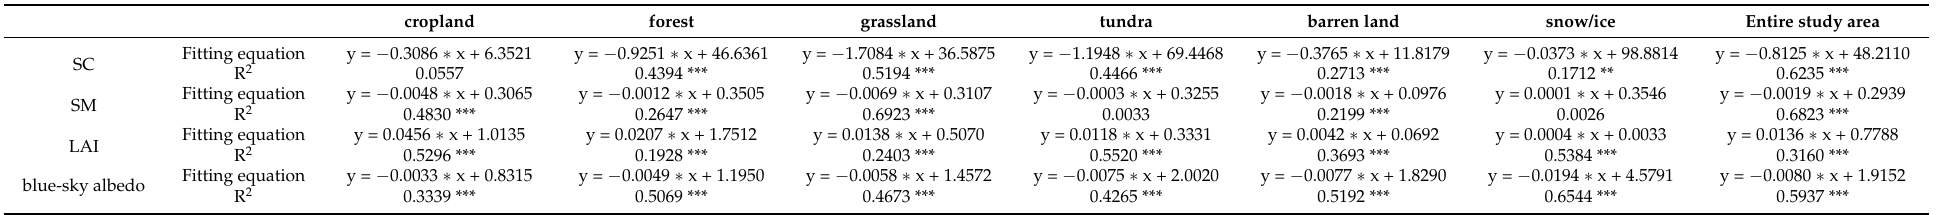
Table 1. Summary of the fitting equation, goodness of fit, and significance test (F test) of annual mean trends of SC, SM, LAI and blue-sky albedo. cropland forest grassland tundra barren land snow/ice Entire study